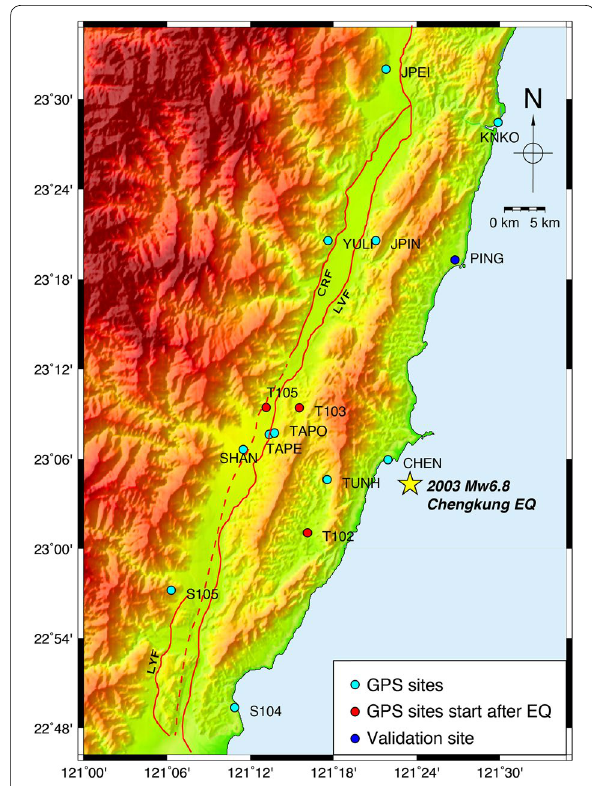
Fig. 1 GPS stations around the epicenter of the 2003 Chengkung earthquake (yellow star) used in this study. Cyan dots are GPS stations with complete time series and red dots are stations with only postseismic time series. Blue dot is the station used for validation of our grid model. Black vectors are interseismic velocities inferred from GPS time series fitting (for blue stations) or interpolated from surrounding stations (for red stations) with respect to ITRF2008. Red lines are active faults (Shyu et al. 2016). LVF longitudinal Valley fault, CRF Central Range fault, LVF Luyeh